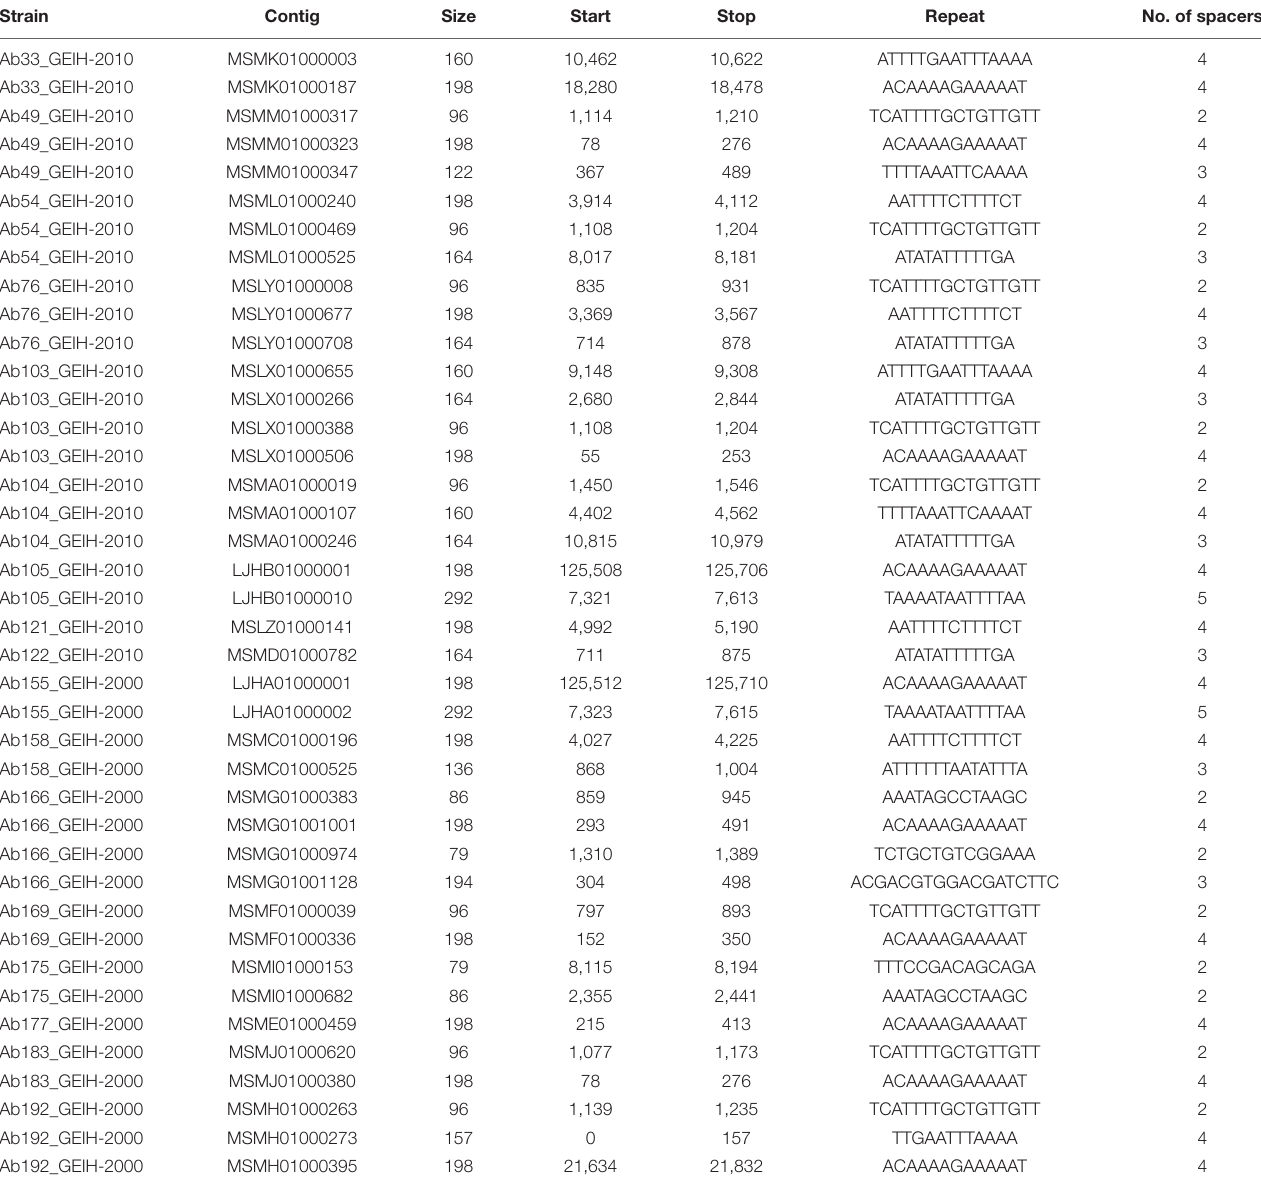
TABLE 1 | CRISPR arrays present in genomes of 18 A. baumannii clinical strains. Strain Contig Size Start